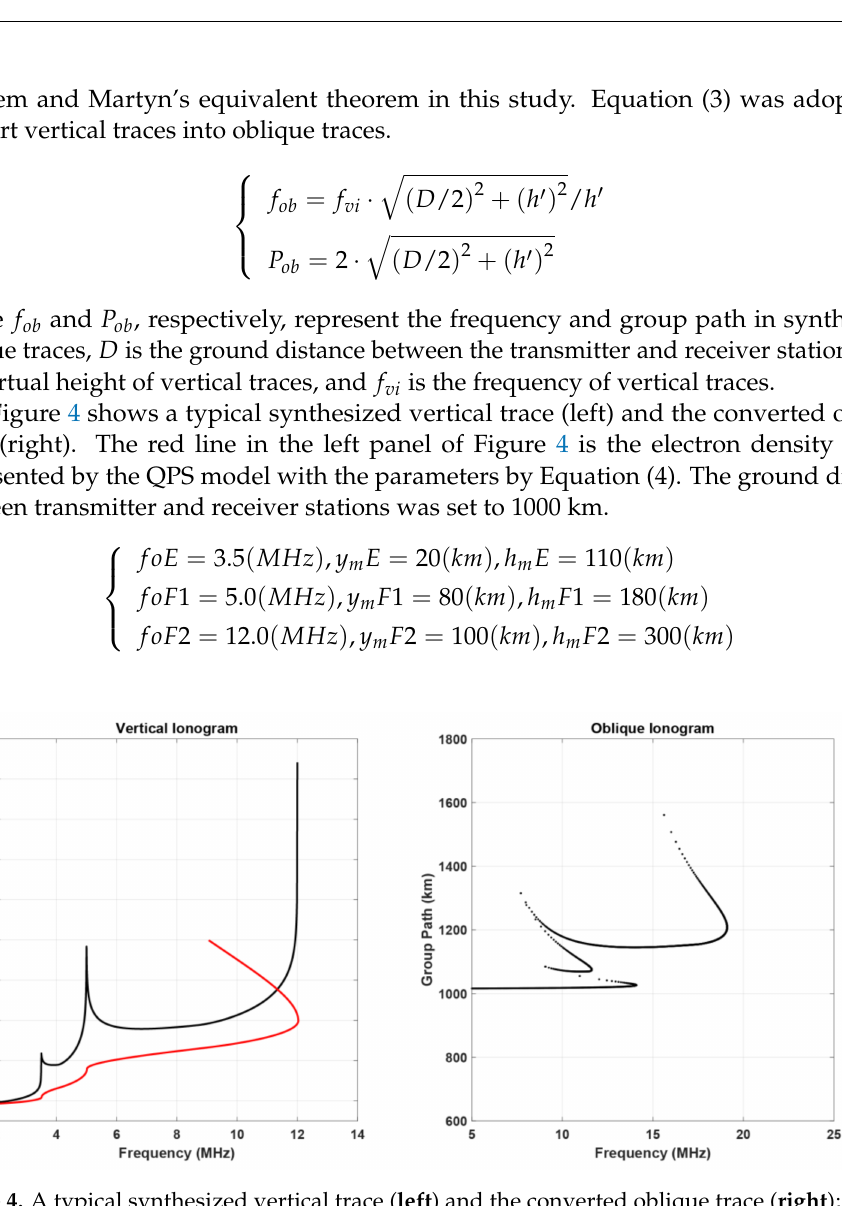
Figure 4. A typical synthesized vertical trace ( left ) and the converted oblique trace ( right ); the red line in the left pane represents the corresponding electron density